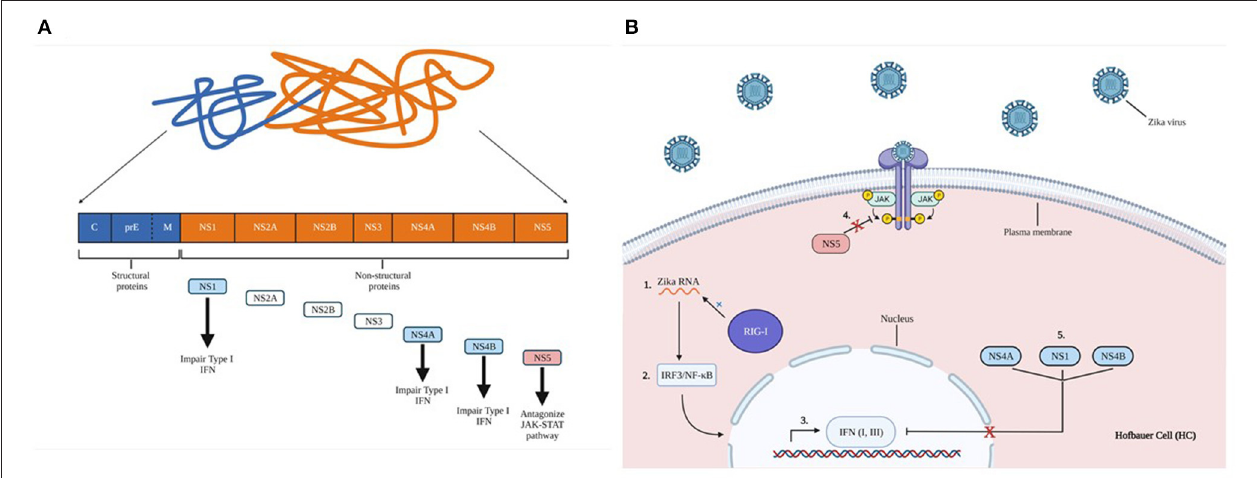
FIGURE 6 | Zika virus non-structural protein impairs innate immune activation. (A) Proteolytic cleavage of zika virus polyprotein. Structural proteins form capsids (C), glycoprotein precursor premembrane (PreM), and envelope proteins (E). Structural proteins are indicated in blue, non-structural proteins are shown in orange. A brief description of each essential non-structural protein are indicated by the arrows . (B) 1) ZIKV RNA is recognized by the retinoic acid-inducible gene I (RIG-1), 2) leading to subsequent activation of IFN regulatory factors such as NF-kB and IRF3. 3) These activate the production of type I and III IFNs, which are mediated by the JAK-STAT signaling pathway to induce cells into an antiviral state. 4) ZIKV non-structural protein NS5 can antagonize JAK-STAT signaling, evading gene activation, and blocking cellular conversion into an antiviral state. 5) NS1, NS4A, NS4B impair type-I IFN